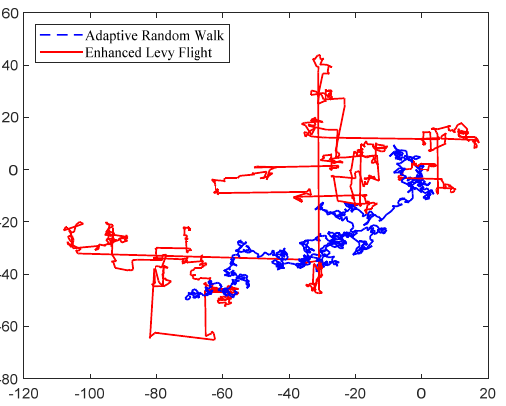
Figure 3. Simulation of enhanced Levy flight and the adaptive random walk strategy.